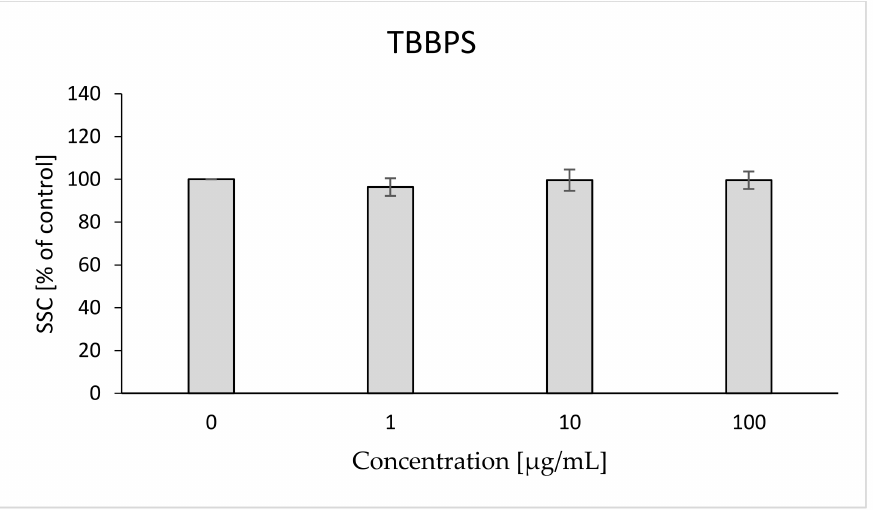
Figure 16. Changes in the SSC parameter in human control erythrocytes and the erythrocytes incubated with TBBPS at 1 to 100 µ g/mL for 48